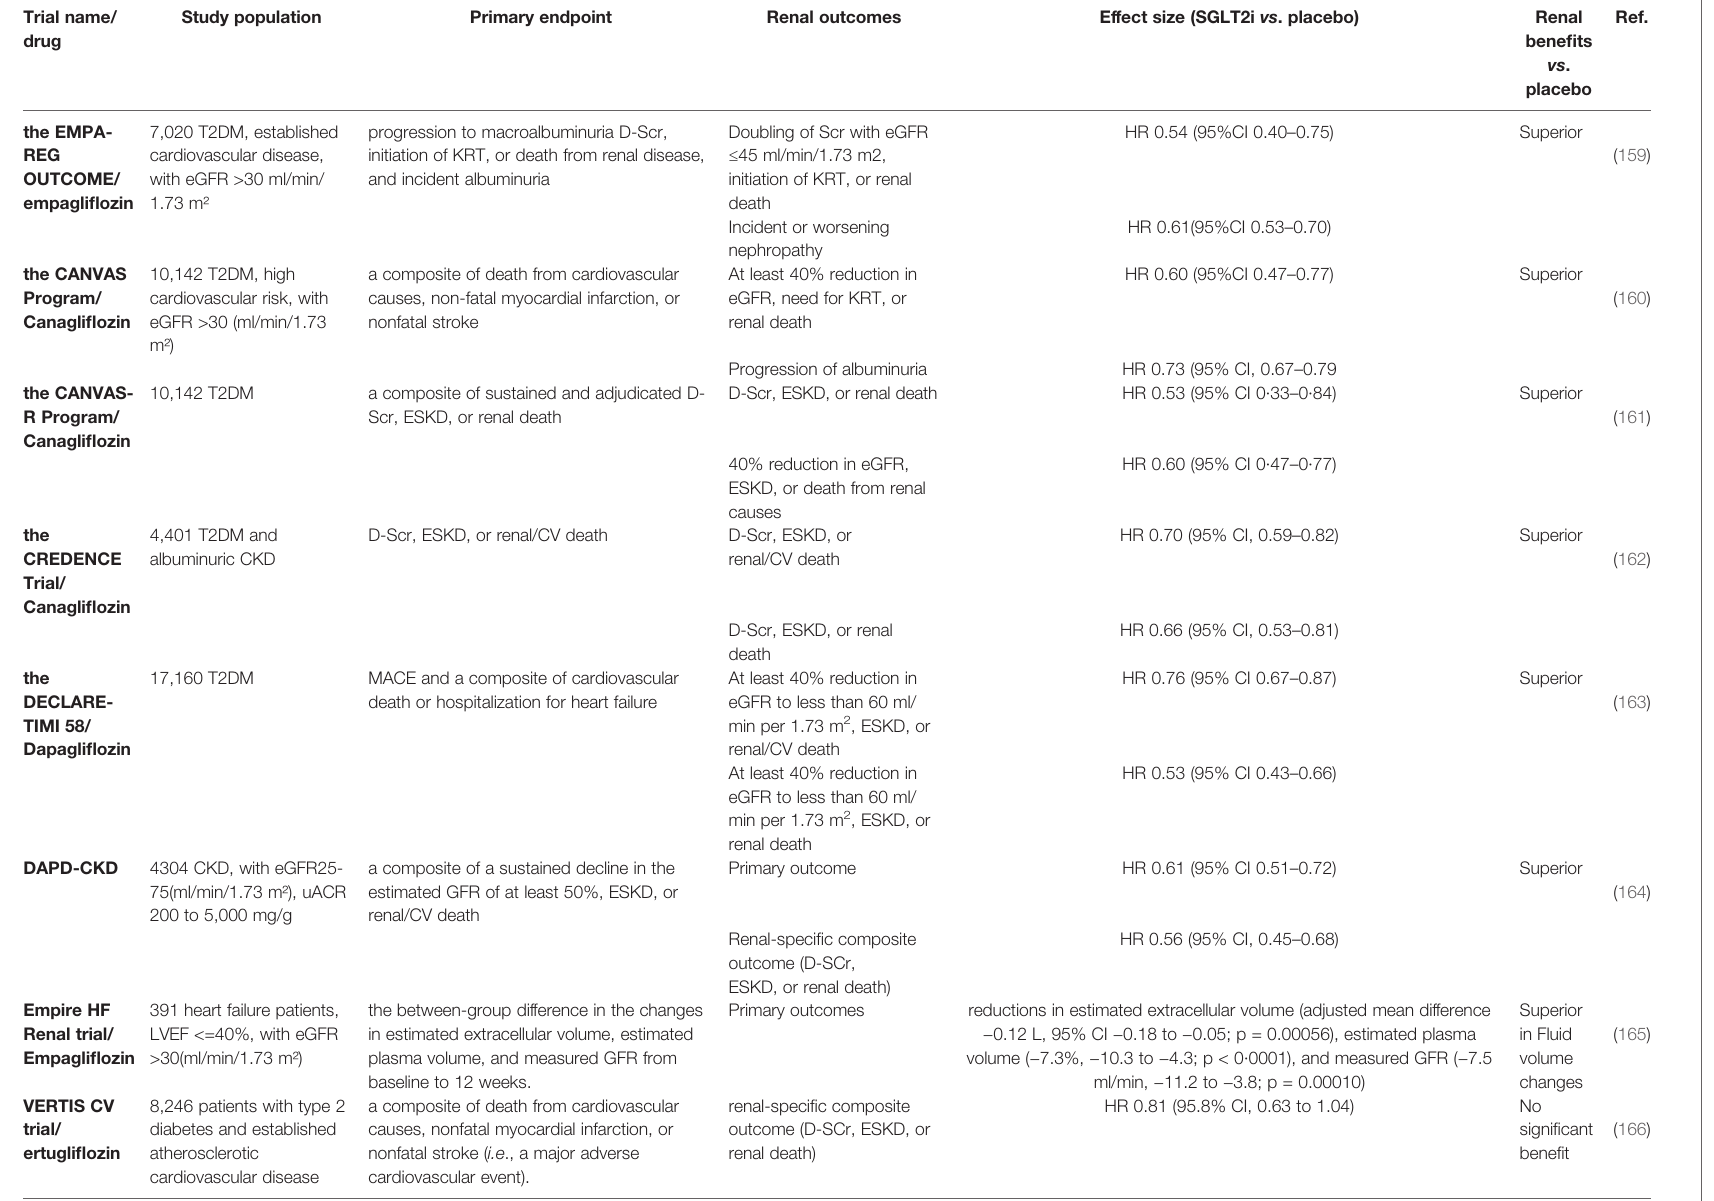
TABLE 3 | Summary of the main renal outcomes of the SGLT2 inhibitors